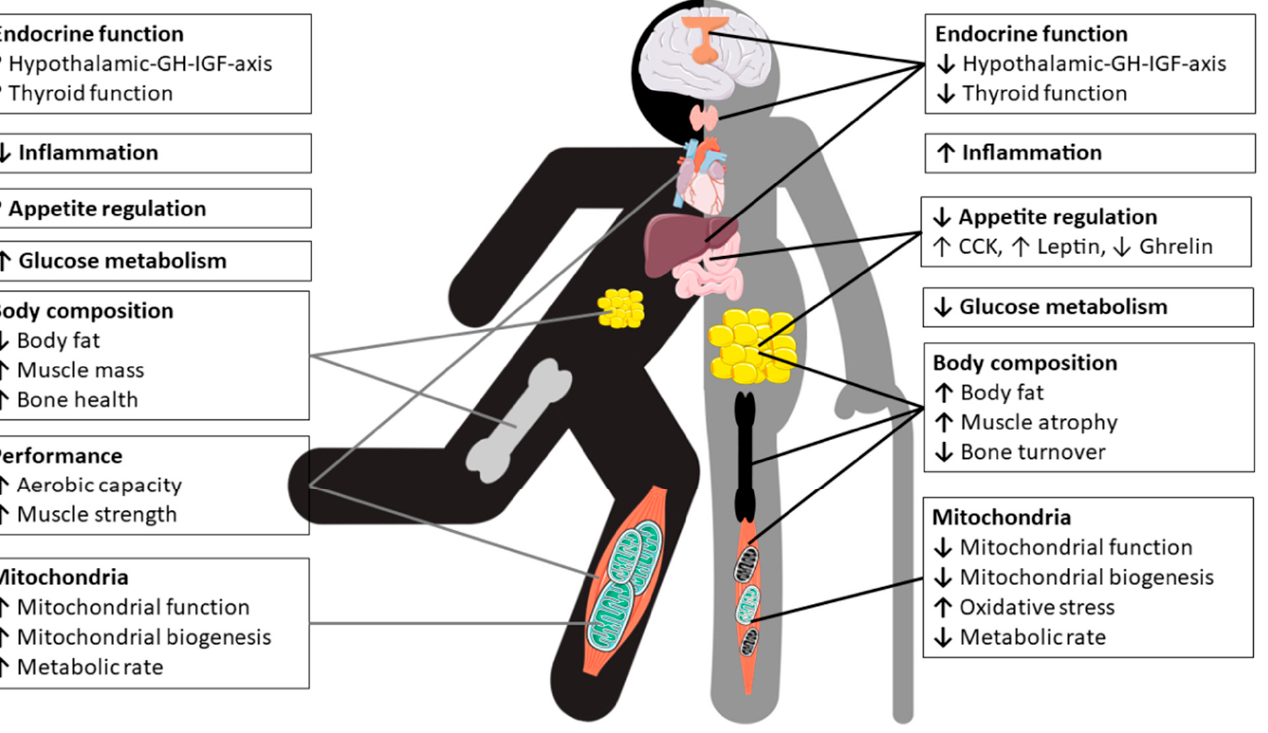
Figure 5. Pleiotropic effects of physical exercise and nutrition on healthy aging. The right side depicts effects of aging on endocrine function, appetite regulation, glucose metabolism, body composition and mitochondria. The left side illustrates how physical exercise can potentially mitigate effects of aging on the human body of masters athletes. ↑ , positive change; ↓ , negative change; ?, unknown effect . Cholecystokinine, CCK; growth hormone, GH; insulin-like growth factor, IGF.